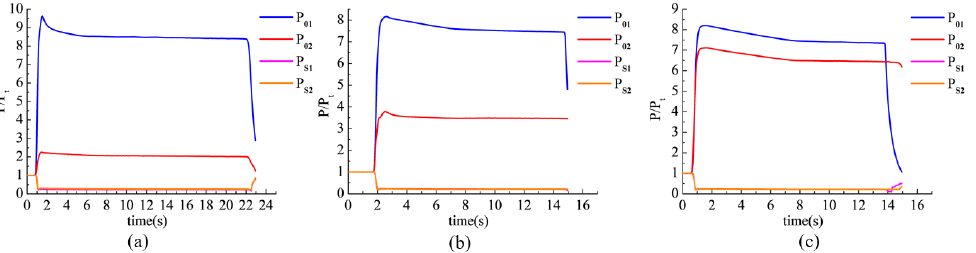
Figure 6. Total and static pressure in operation (normalized by local atmospheric pressure p t ) ( a ) case 1, ( b ) case 2, ( c ) case 3.